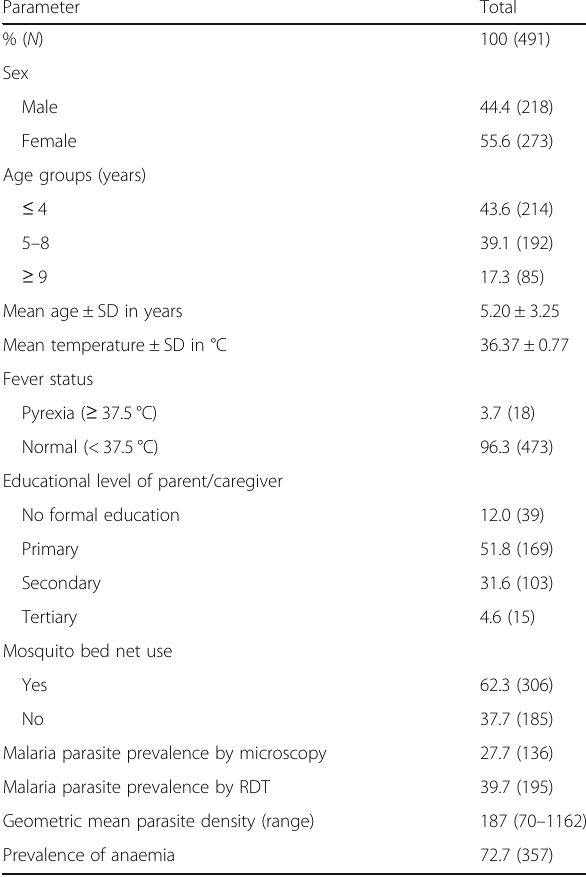
Table 1 Baseline characteristics of study